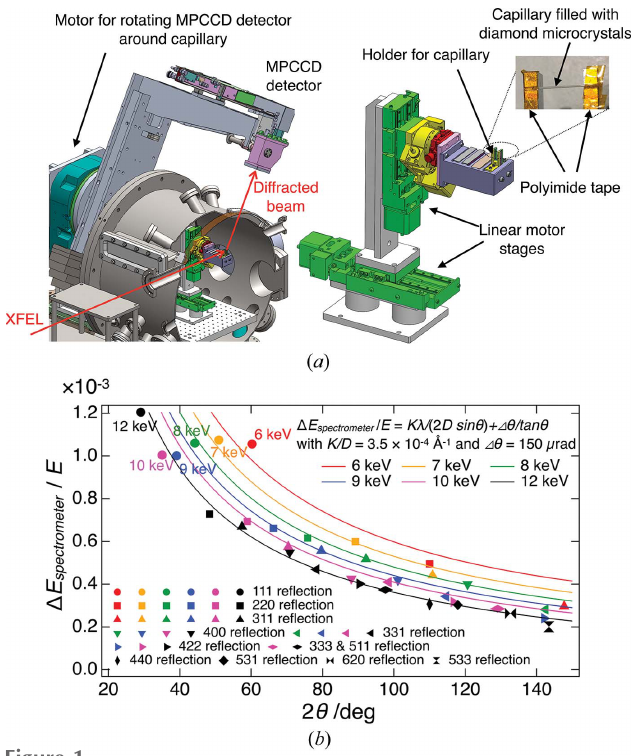
Figure 1 ( a ) A schematic of the spectrometer using diamond microcrystals in EH1 of SACLA BL3. ( b ) The energy resolution of the spectrometer evaluated with the monochromated XFEL pulses. Solid curves show expected energy resolution of the spectrometer for the case when K / D = 3.5 (cid:6) 10 (cid:4) 4 A˚ (cid:4) 1 and (cid:2) (cid:2) = 150 m